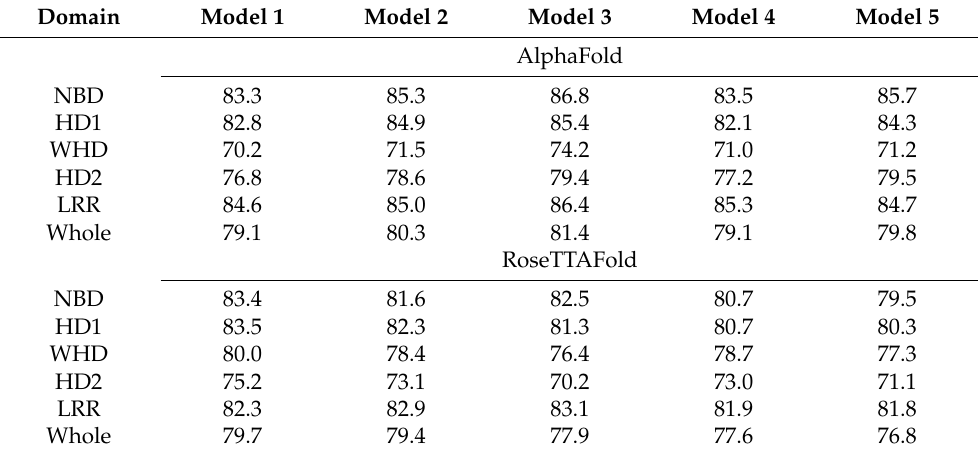
Table 1. Predicted Local Distance Difference Test (pLDDT) and predicted Templated Modeling (pTM) scores for the NLRP3 protein structures generated using AphaFold and RoseTTAFold.